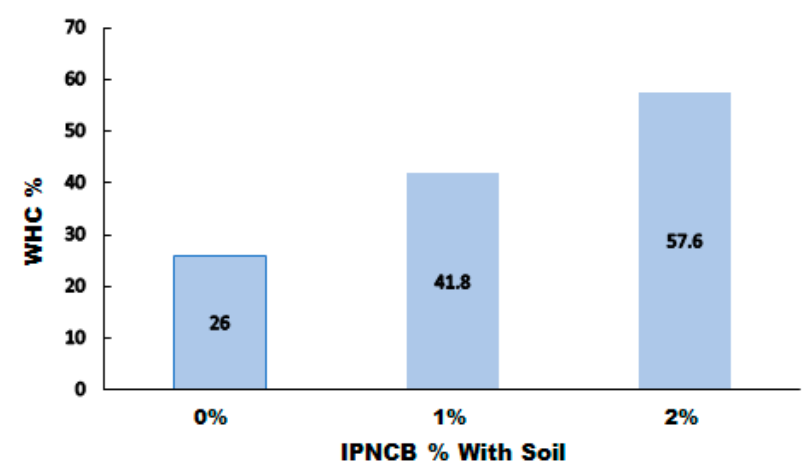
Figure 9. Effect of BC ratio (%) on water holding capacity (WHC).